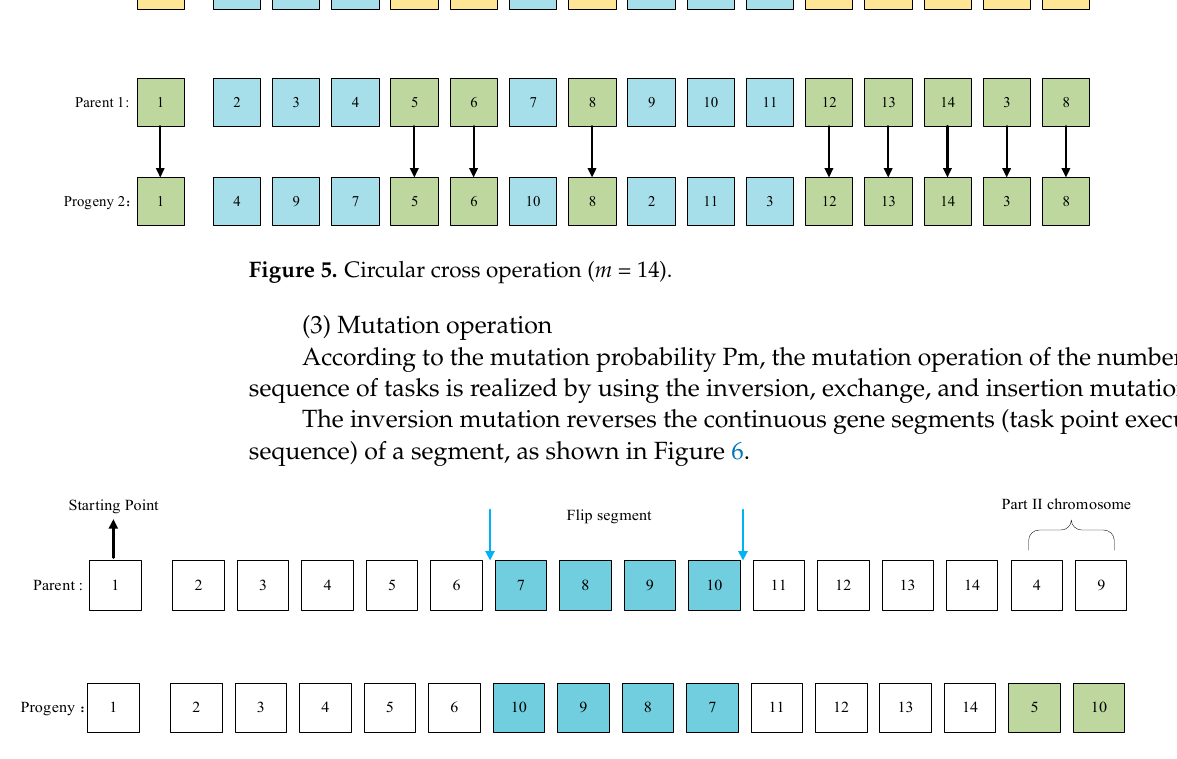
Figure 6. Inversion mutation operation ( m = 14).